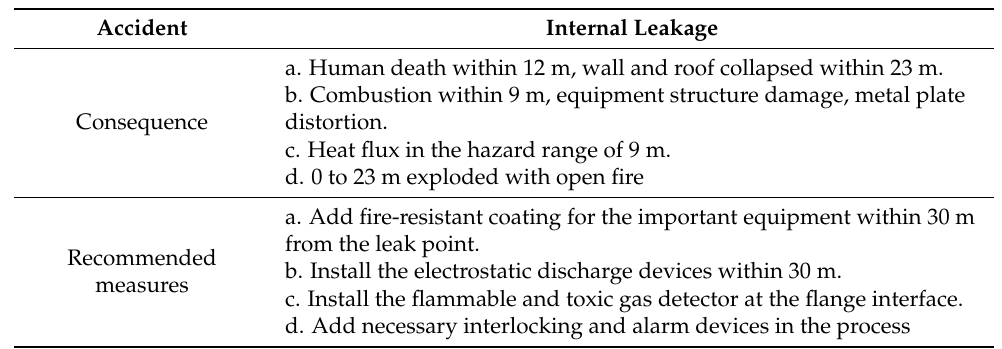
Table 9. The safety analysis report of